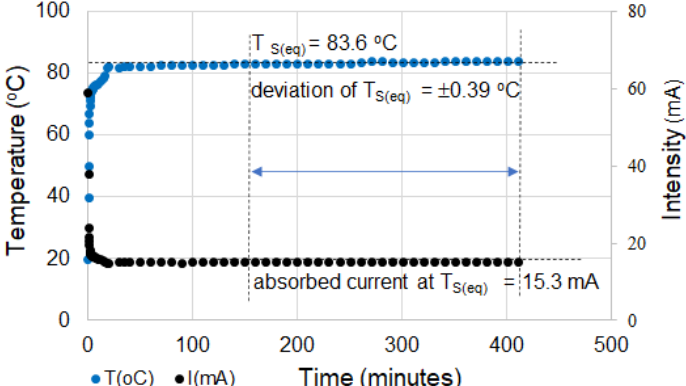
Figure 17. T s vs. time and current intensity through the sample vs. time for a (CB + Gr)/HD composite (applied voltage, 55 V).